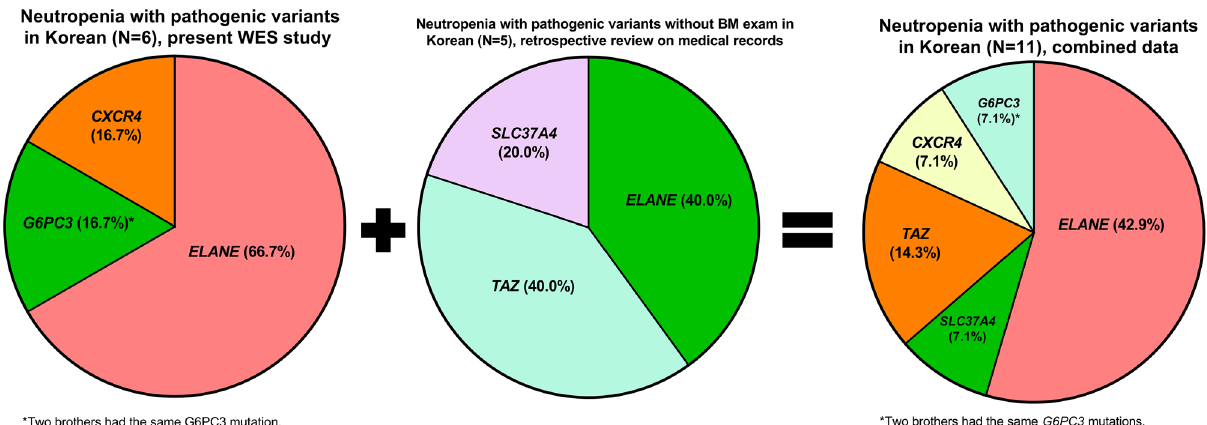
Figure 5. Comprehensive data on disease-causing genetic variants in 11 neutropenia patients obtained by combining this WES study results of the 6 patients and medical records of another 5 patients for whom BM exam was not performed. Focusing on the 11 patients with pathogenic genetic variants including 8 patients without BM exam, variants in an ELANE gene were the most common (n = 6, 42.9%), followed by TAZ (n = 2, 14.3%), G6PC3 (n = 1, 7.1%), CXCR4 (n = 1, 7.1%) and SLC37A4 (n = 1,